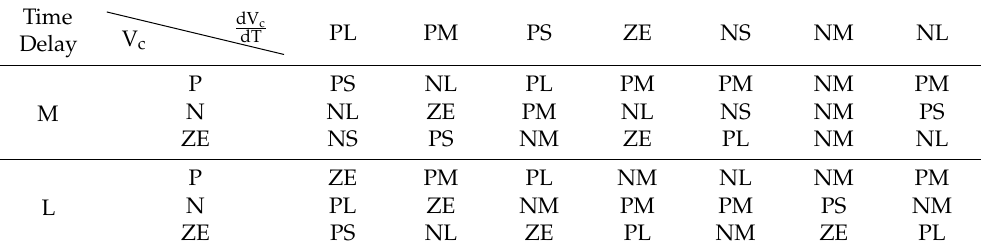
Figure 11. Time-delay signal of Vc. Table 6. Rule based on delay-compensated FLWADC. Table 6. Rule based on delay-compensated FLWADC.